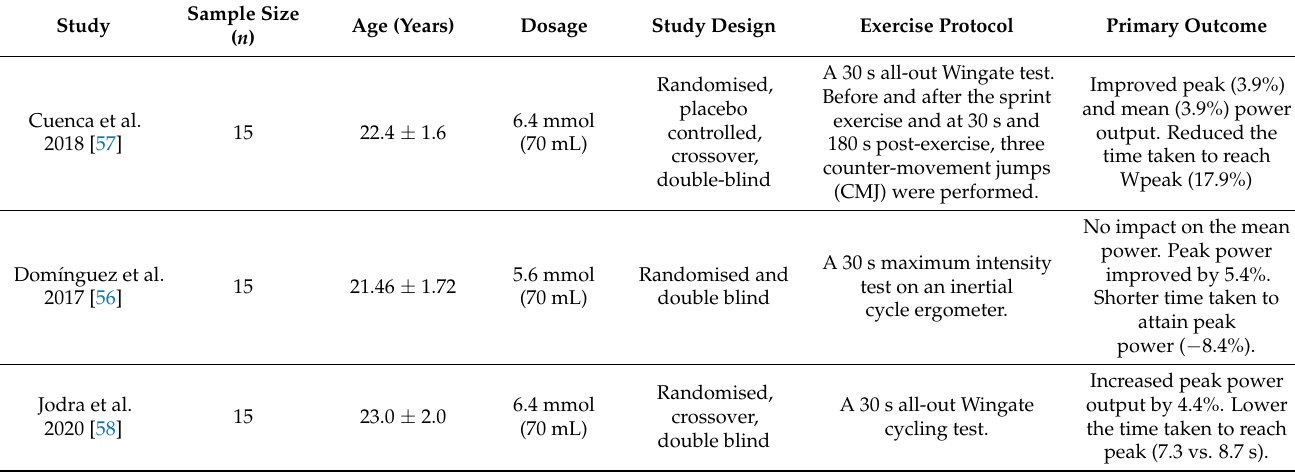
Table A2. Studies examining the acute effect of beetroot supplementation on isolated 30 s sprints (Wingate tests).